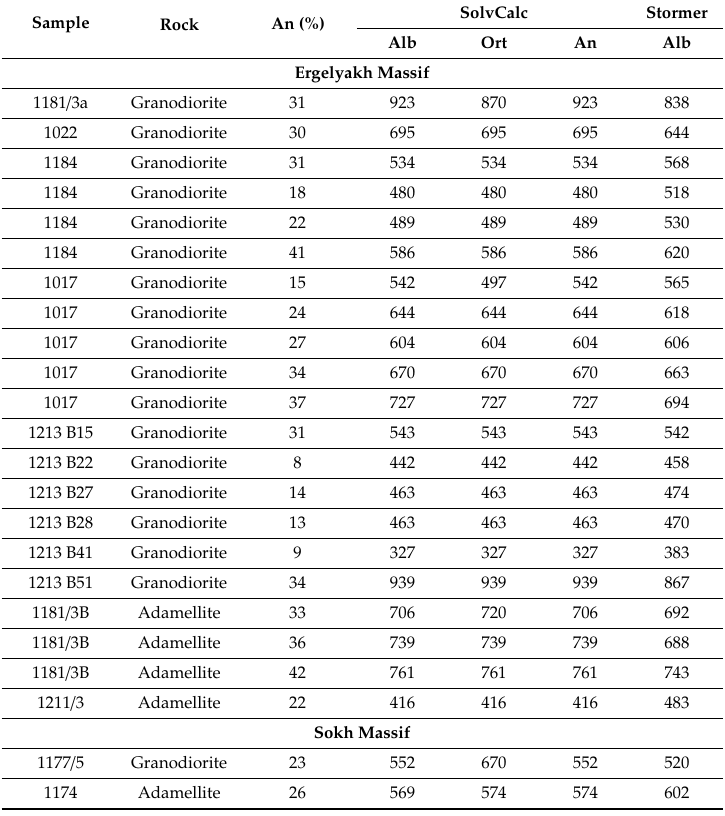
Table 12. Formation temperatures of feldspars from EIRGD